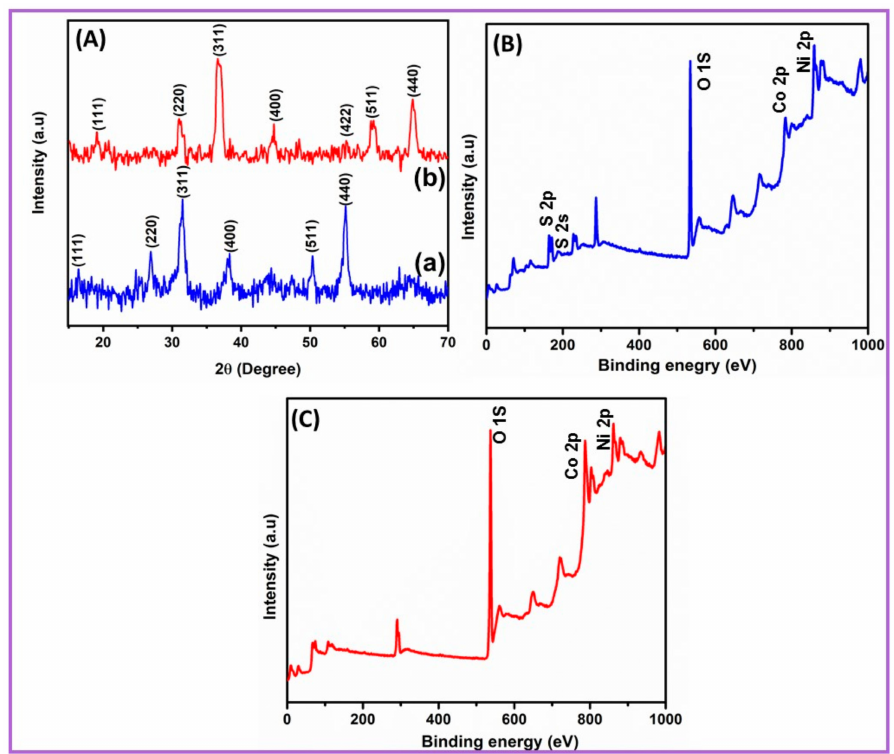
Figure 3. ( A )—( a ) XRD study of NiCo 2 S 4 -Ms and ( b ) NiCo 2 O 4 -MFs. ( B ) XPS survey spectrum of NiCo 2 S 4 -Ms and ( C ) NiCo 2 O 4